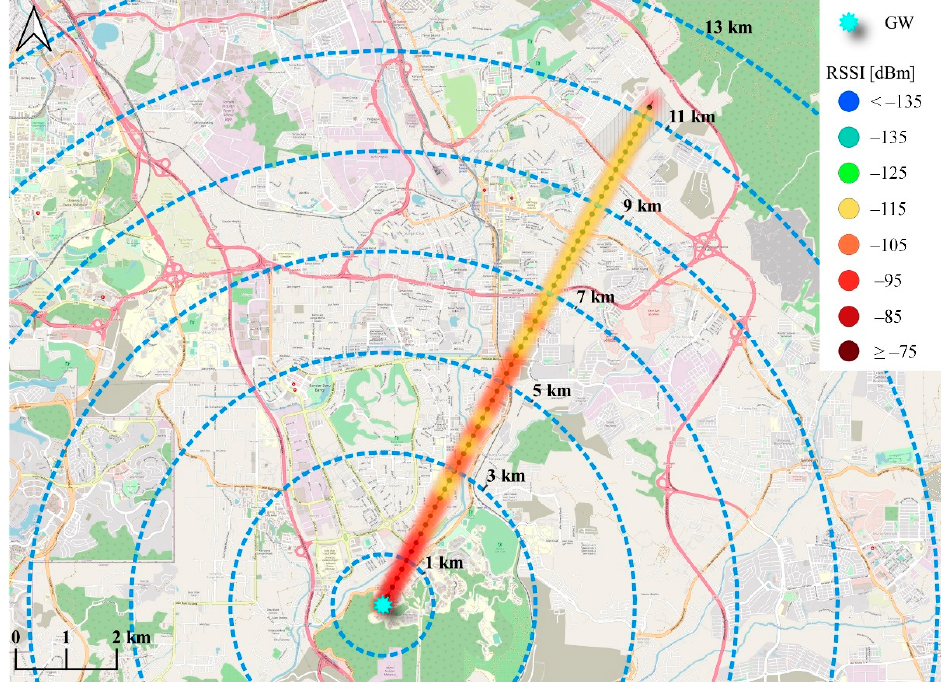
Figure 10. Measurement route at the UKM campus area (Bangi, Malaysia) and the heatmap of LoRaWAN ® coverage throughout the measurement route.